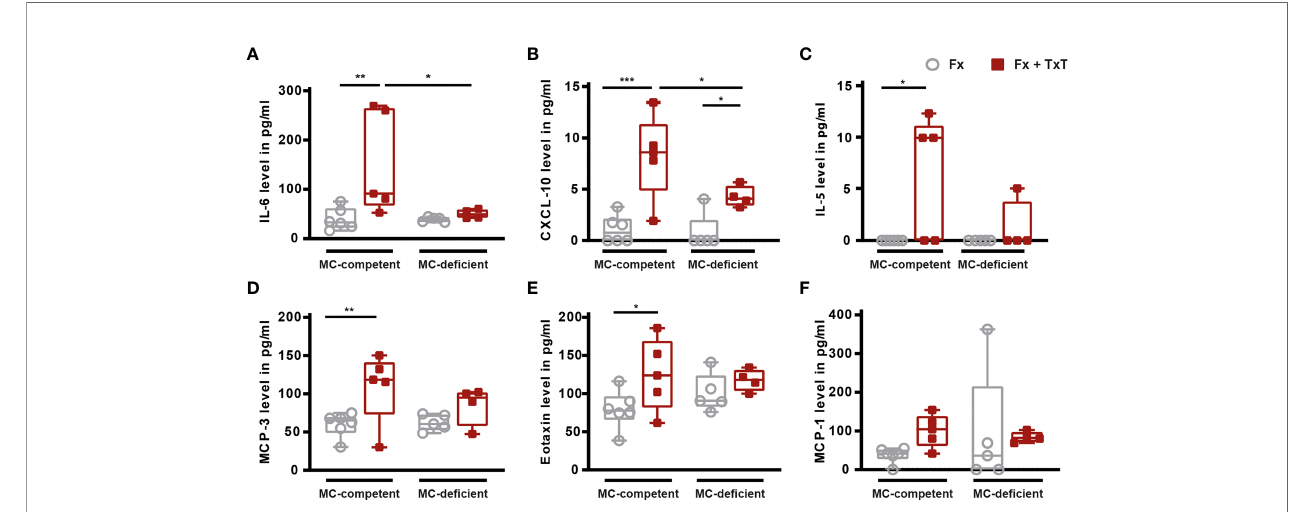
FIGURE 1 | In fl ammatory mediator concentrations in serum of mast cell (MC)-competent and MC-de fi cient mice 3 h after isolated fracture (Fx) and combined fracture and thoracic trauma (Fx + TxT). Serum (A) interleukin-6 (IL-6), (B) C-X-C motif chemokine ligand 10 (CXCL-10), (C) IL-5, (D) monocyte chemoattractant protein-3 (MCP-3), (E) eotaxin, and (F) MCP-1 levels. Gray boxes represent Fx mice, red boxes represent Fx + TxT mice. Data are shown as box-and-whisker plots (with median and interquartile range) from maximum to minimum, showing all data points. *p<0.05; **p<0.01; ***p<0.001. The p values were determined using one- way ANOVA with post hoc Fisher ’ s LSD in the case of normal distribution or with Kruskal-Wallis with post hoc Dunn ’ s test if data were not normally